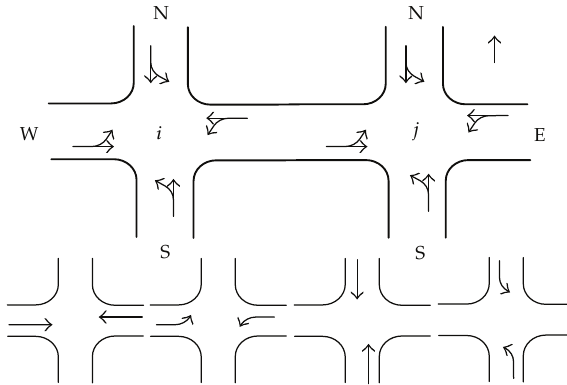
Figure 1: Main direction of tra ffi c flows and phase-sequence at saturated arterial adjacent intersections.